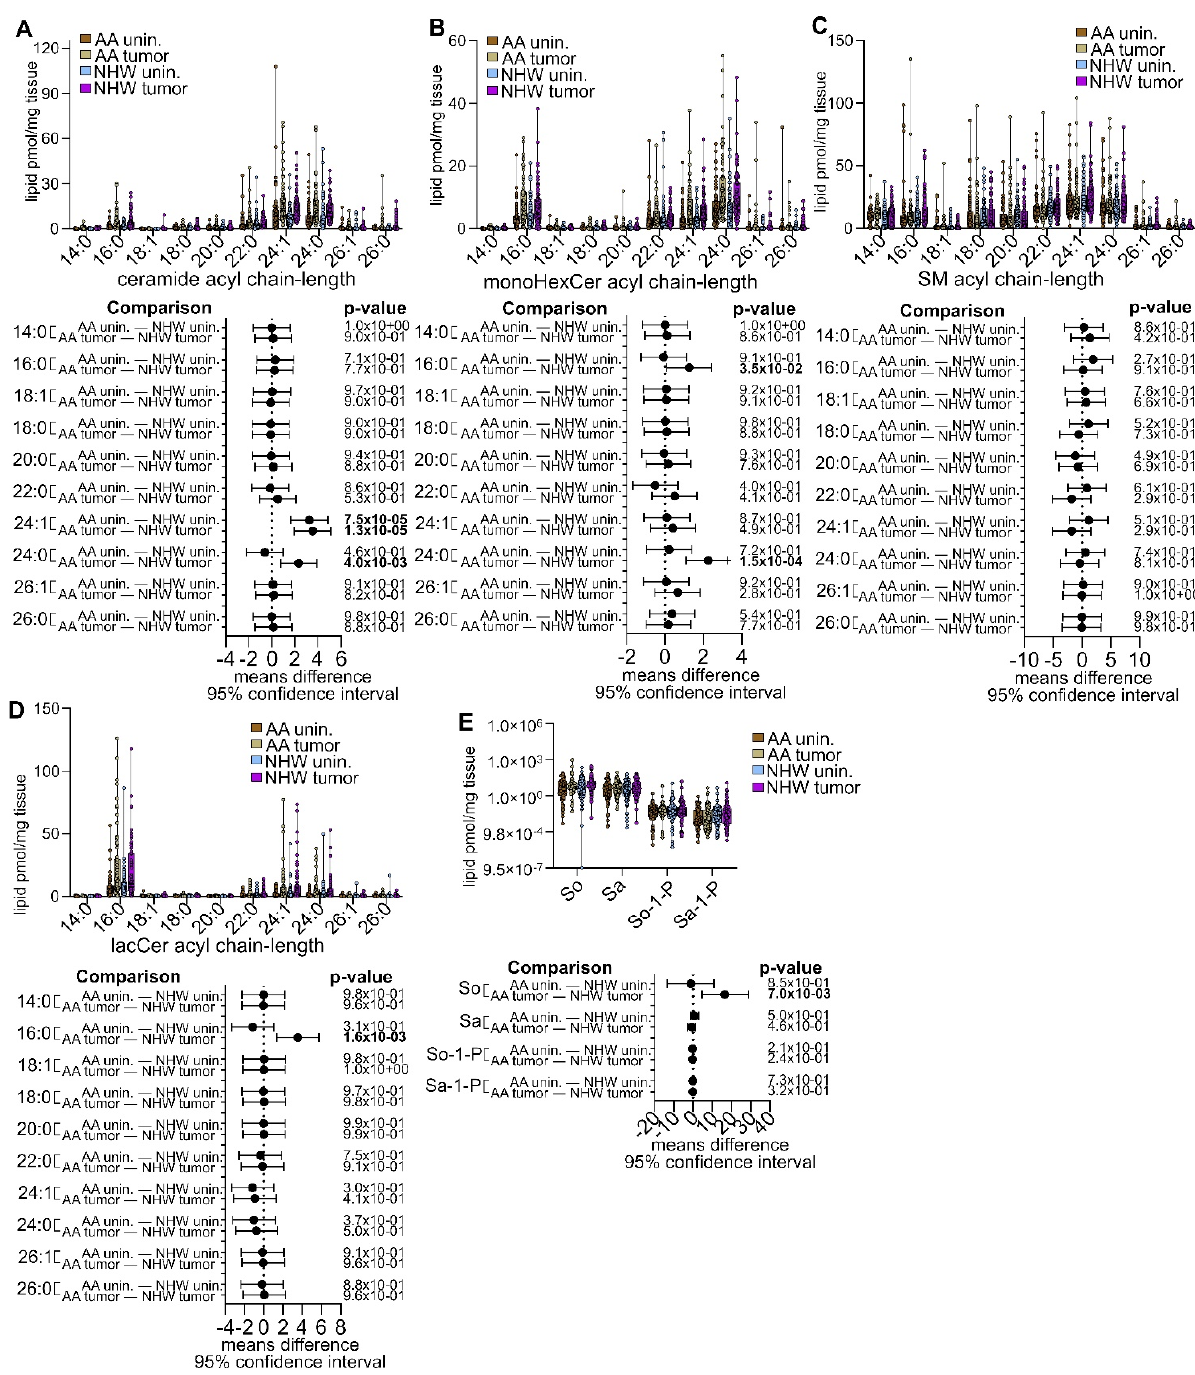
Figure 10. Race-dependent pan-cancer analysis of differences in the unin. and tumor tissues of AA and NHW subjects with LUAD, COAD, HCC, EEC, and HNSCC. Data from AA and NHW presented in Figures 2 and 3 were pooled by race, sphingolipid class, and acyl chain length and analyzed to examine differences between the unin. and tumor tissues of AA and NHW with pan-cancer. In each panel ( A – E ), the upper graphs are box plots showing medians (black line) and whiskers of min to max (top), and the bottom graphs are plots of the 95% family-wise significance and confidence intervals for predicted means difference (means diff.) calculated following ANOVA. The mean fold-change between unin. tissue and tumor was calculated by dividing the calculated mean lipid level in tumors by the mean lipid level in unin. tissues and shown between parenthesis next to the corresponding unadjusted p -values (Fisher’s LSD; Prism). The lower limit of p - and q-value calculations was set to 1.0 × 10 -15 (Prism), so no values are reported lower than this limit. For p -adjusted